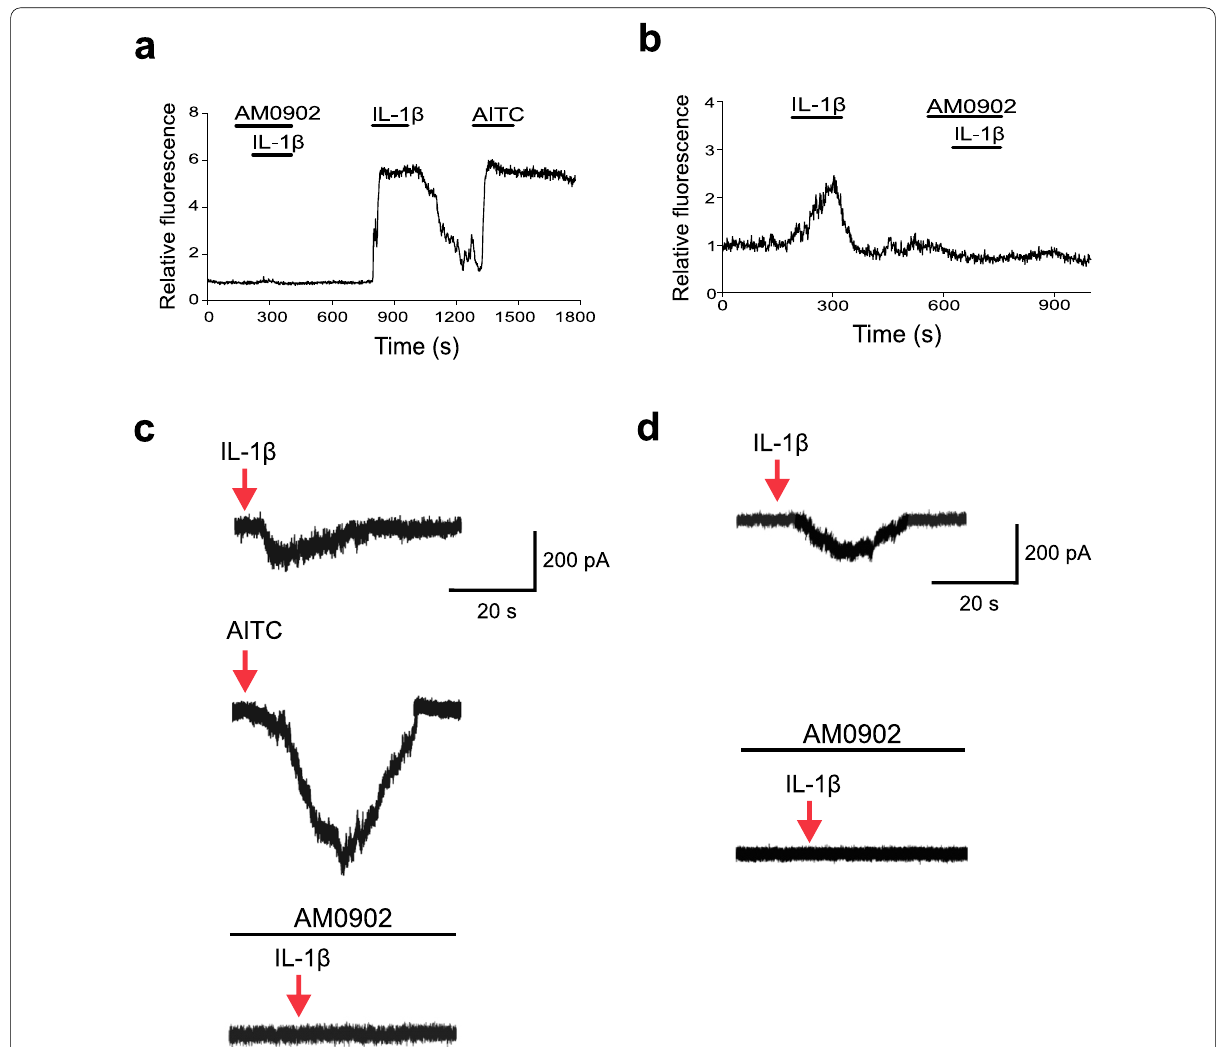
Fig. 3 TRPA1 antagonist blocks IL-1β induced calcium flux and current in nodose ganglion sensory neurons. a , b Nodose ganglion sensory neurons harvested from VGlut2-cre/GCaMP3 mice were stimulated with IL-1β (20 µg/mL), AITC (100 µM; TRPA1-agonist) and AM0902 (10